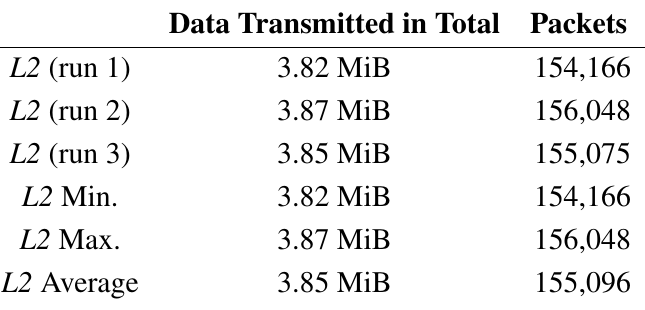
Table 5. Data transmission statistics for L2